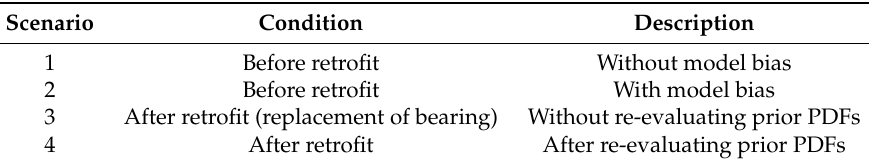
Table 4. Cases of structural identification considered for comparison of four data-interpretation